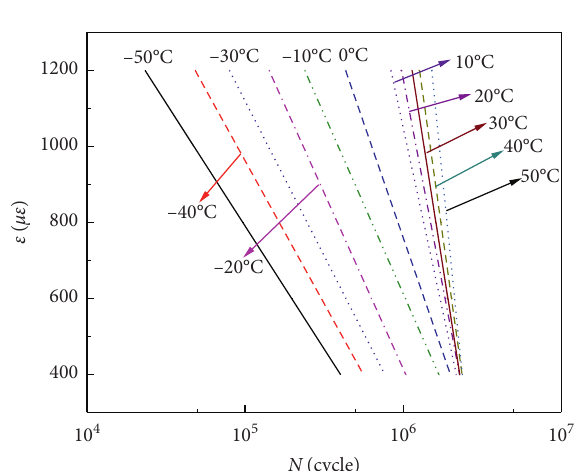
Figure 12: Fatigue life curves at different